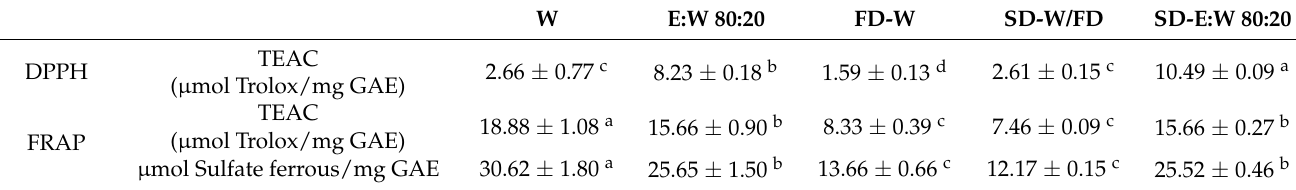
Table 5. AOA of extracts before and after processing by freeze and spray